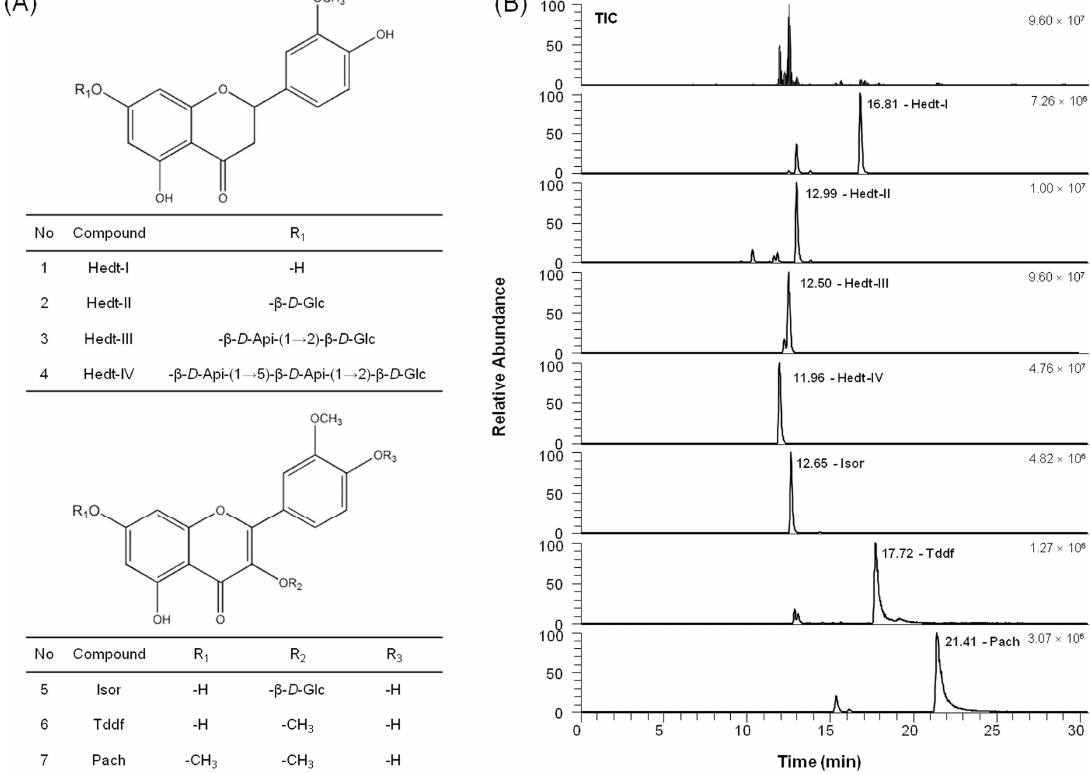
Figure 6. The chemical structures and the PRM chromatograms in the negative mode of VEE. The structures and PRM chromatograms of seven compounds in VEE are shown. Hedt-I, Hedt-II, Hedt-III, Hedt-IV, Isor, Tddf, and Pach were identified. UHPLC-Q-Exactive Orbitrap-MS analysis was performed as described in the Materials and Methods section. ( A ) The chemical structures; ( B ) PRM chromatograms.